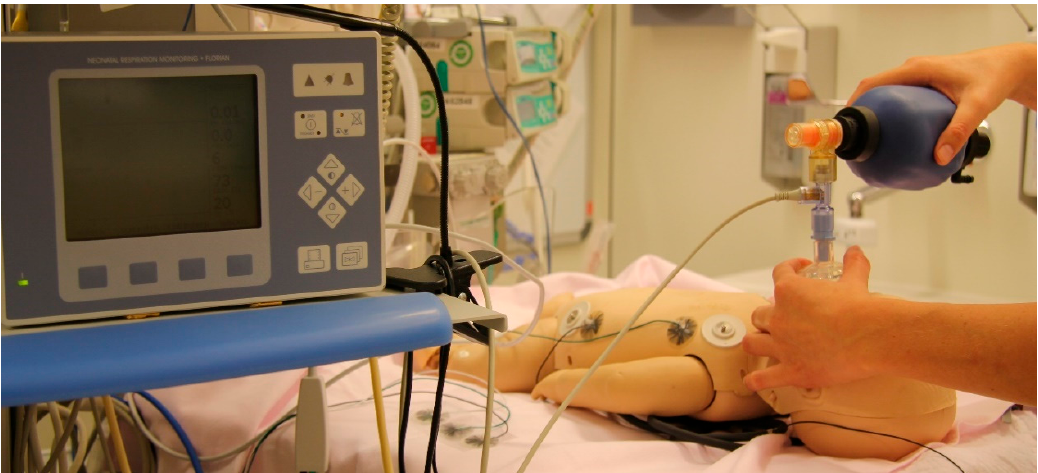
Figure 1. The experimental set-up consisted of a modified leak-free baby manikin, a self-inflating bag, and a respiratory function monitor.